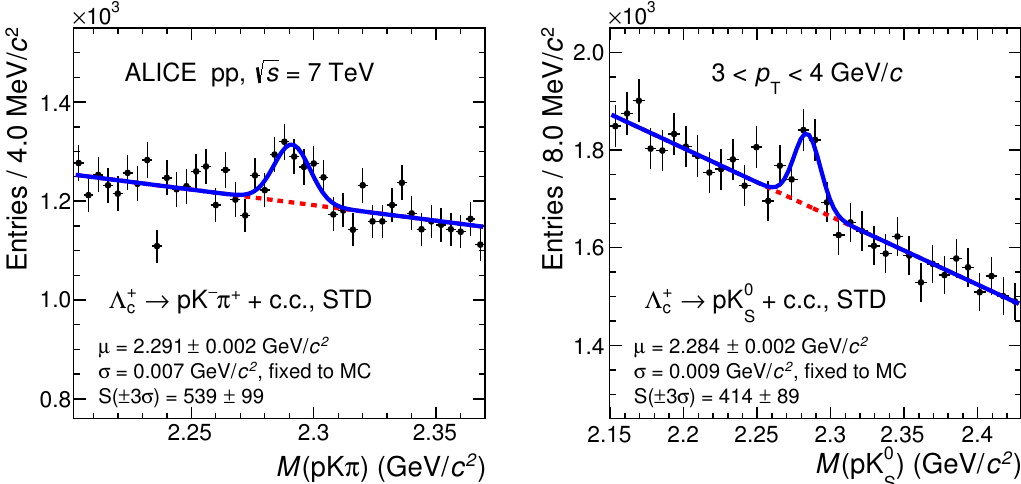
Figure 3 . Invariant-mass distribution of (cid:3) + GeV/ c in pp collisions at the solid lines represent the total (cid:12)t function. Left: (cid:3) + STD